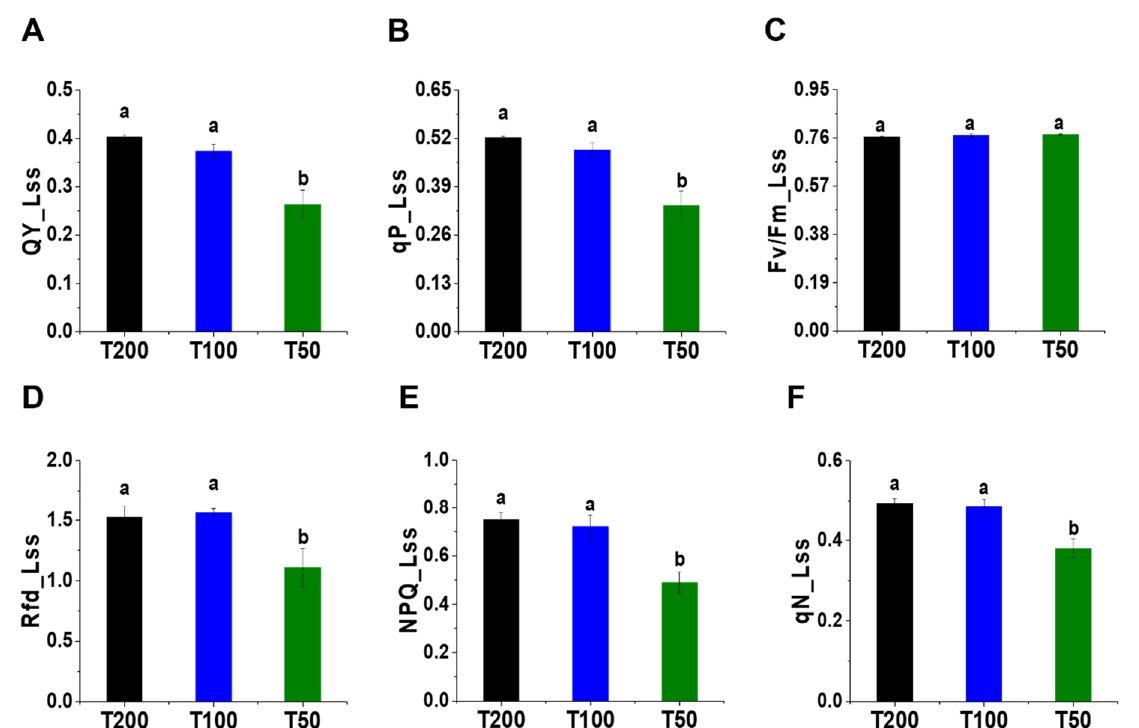
Figure 4. Effect of different light intensities on QY_Lss ( A ), qP_Lss ( B ), Fv/Fm_Lss ( C ), Rfd_Lss ( D ), NPQ_Lss ( E ), and qN_Lss ( F ). The values are expressed as mean ± SE. The lowercase letters on each column show significant differences at p < 0.05 using the LSD test. T200 symbolizes the seedlings under a light intensity of 200 µ mol m − 2 s − 1 ; T100 symbolizes the seedlings under a light intensity of 100 µ mol m − 2 s − 1 ; and T50 symbolizes the seedlings under a light intensity of 50 µ mol m − 2 s − 1 .